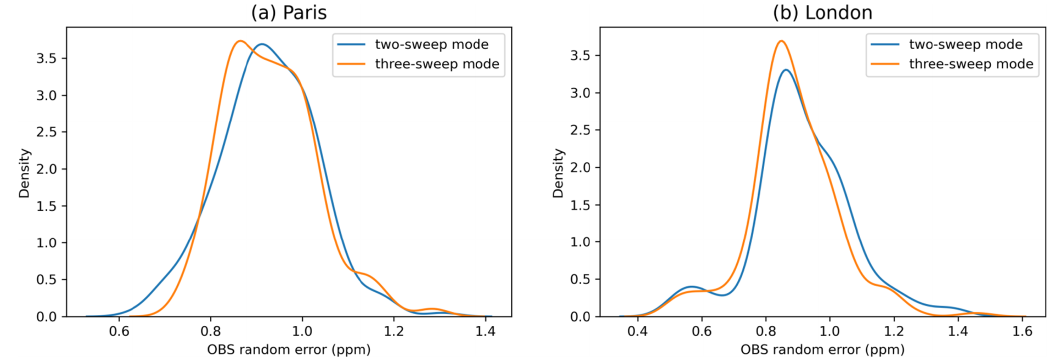
Figure A5. Probability density of the observation uncertainty (random measurement error) in Paris (a) and London (b) .